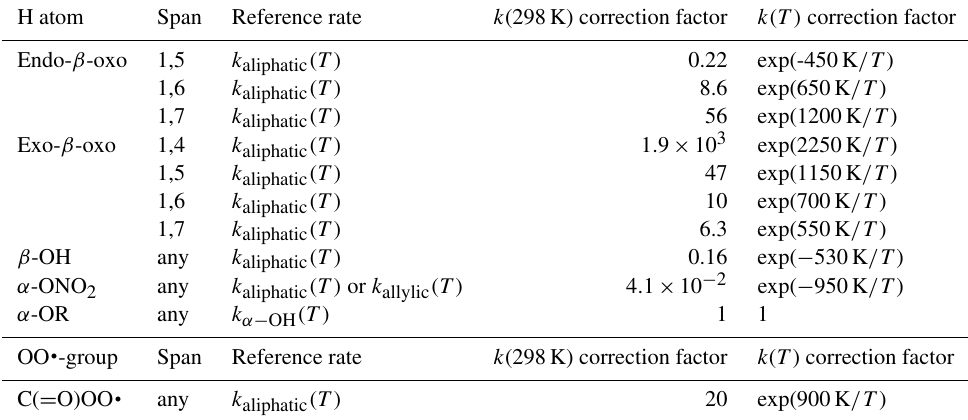
Table 5. Rate coefficients corrections for oxo-, hydroxy-, nitrate- or alkoxy-substituted H atoms in RO 2 radicals or for acyl peroxy radicals, relative to H migration in aliphatic peroxy radicals, accounting for all abstractable H atoms in the group. H atom Span Reference